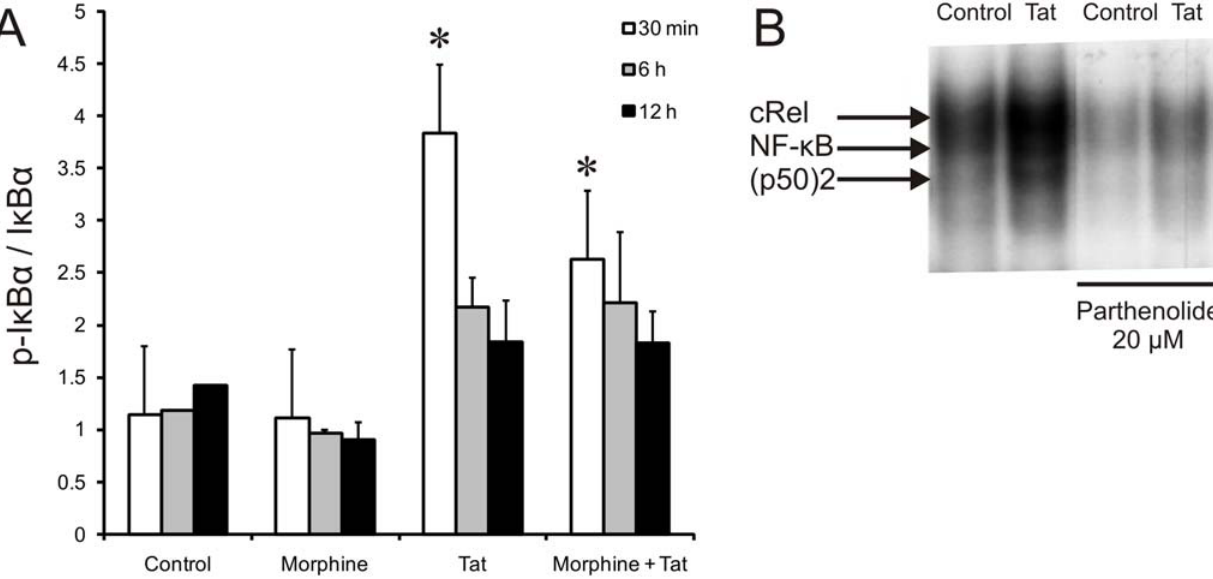
Figure 2. Tat phosphorylates I k B a in astrocytes. To verify that I k B a is phosphorylated in our cell culture system, astrocytes were treated with Tat alone or in combination with morphine for 30 min, 2 and 6 h (A). Increases in I k B a phosphorylation were noted in cell lysates treated with Tat 6 morphine at 30 min compared to treatment with vehicle or morphine alone (* P , 0.05 vs. controls at 30 min). After 6 h, the amount of phosphorylated I k B a was equal in cell lysates treated with Tat alone or Tat plus morphine (A). Down regulation of NF- k B (p65), c-Rel and p50 by parthenolide. Nuclear extracts from cells treated with or without Tat 6 parthenolide for 24 h were subjected to electromobility shift assay (EMSA) with labeled NF- k B oligonucleotide (B). Nuclear extracts containing parthenolide showed a down regulation in NF- k B DNA binding activity as compared to the DNA binding activity of nuclear extract without parthenolide.